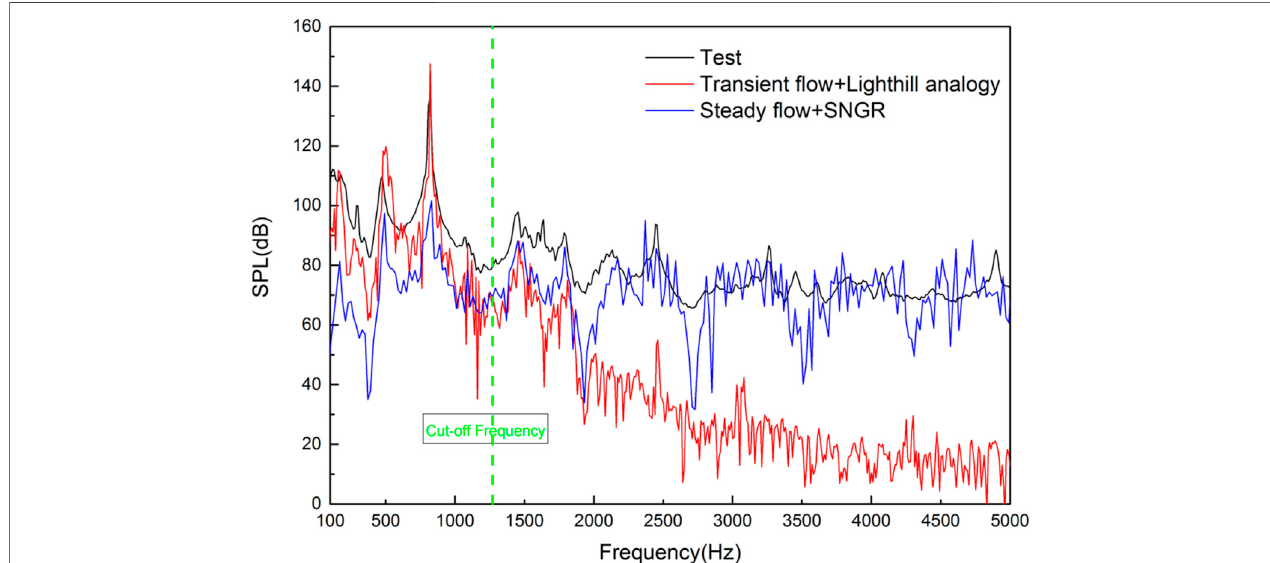
FIGURE 13 | The SPL spectrum of P5 for different